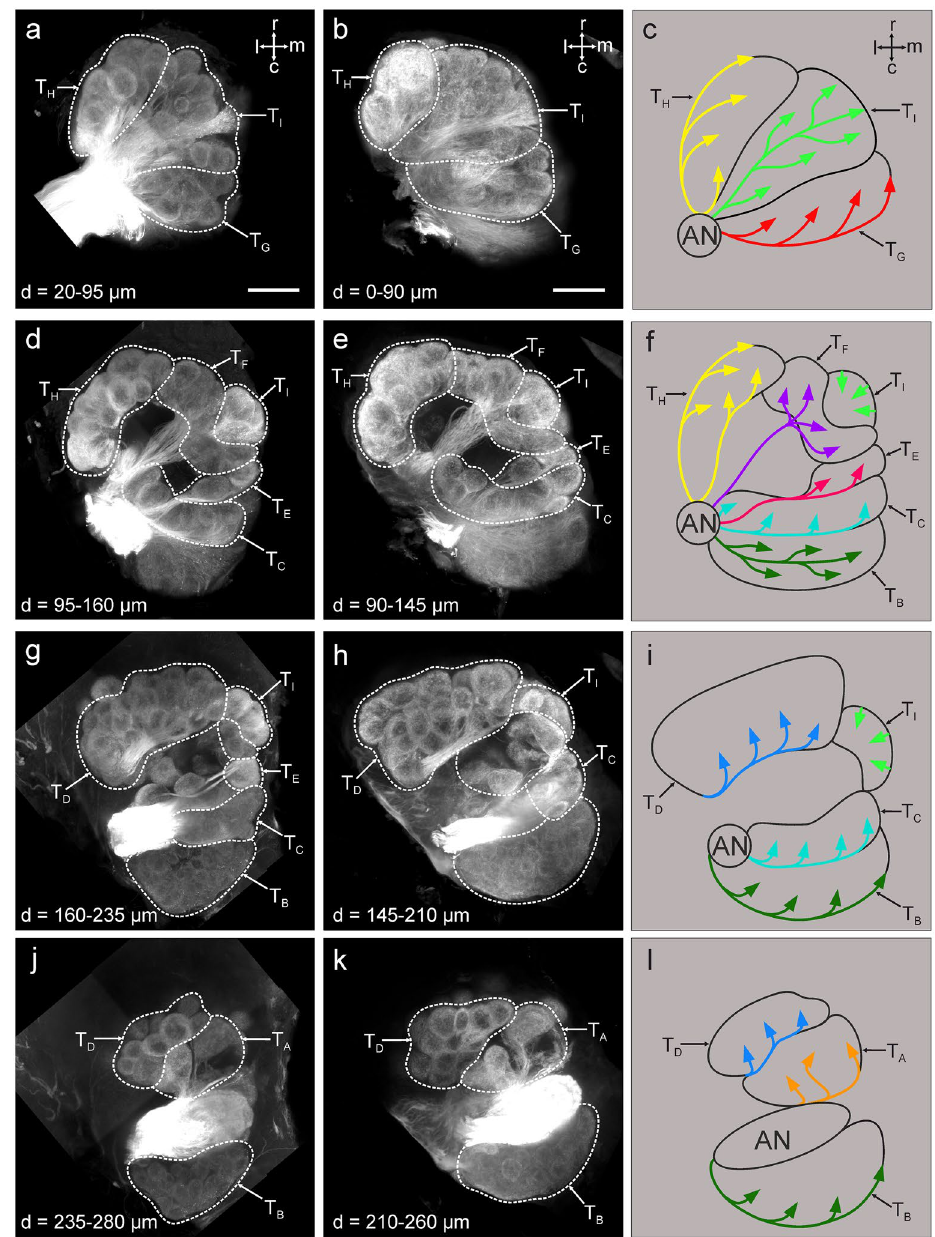
Figure 1. Antennal lobe organization in hornets. Projection view starting from the ventral surface to the dorsal surface of a right antennal lobe after mass staining of the antennal nerve in V. velutina ( a , d , g , j ) and V. crabro ( b , e , h , k ). The antennal lobes are similarly organized as both species exhibit 9 olfactory sensory tracts (T A –T I ; c , f , i , l ) which innervate similar clusters of glomeruli in both species. r, rostral; c, caudal; m, medial; l, lateral. All directions follow the neuraxis. Depth (d) from the ventral surface is indicated on each panel. The scale bars in ( a ) (applies to d , g , j ) and ( b ) (applies to e , h , k ) correspond to 100